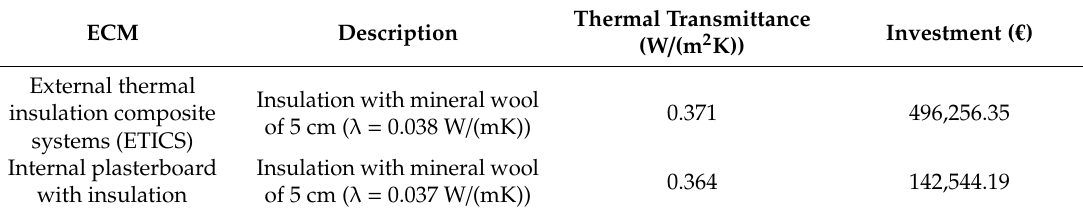
Table 2. Energy conservation measures (ECMs) analyzed in the research.